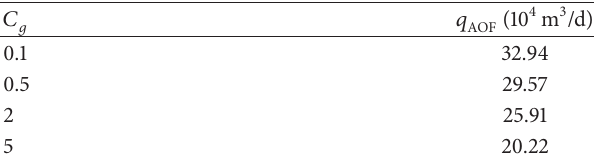
Table 4: The absolute open flow rate in different gas-soluble